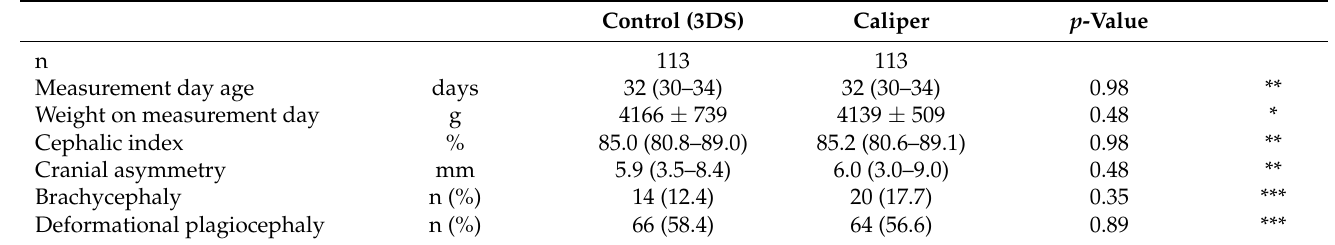
Table 5. Comparison of symmetry-related parameters after